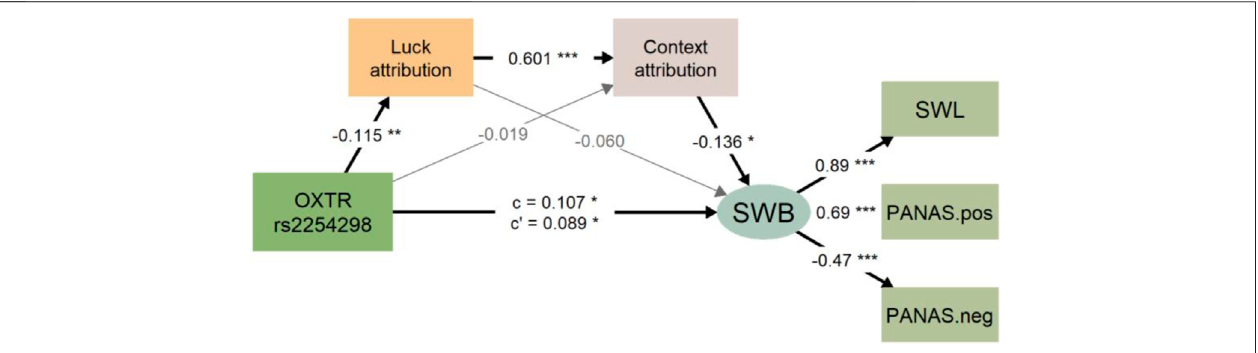
TABLE 4 | Multiple mediation model test with bootstrapping